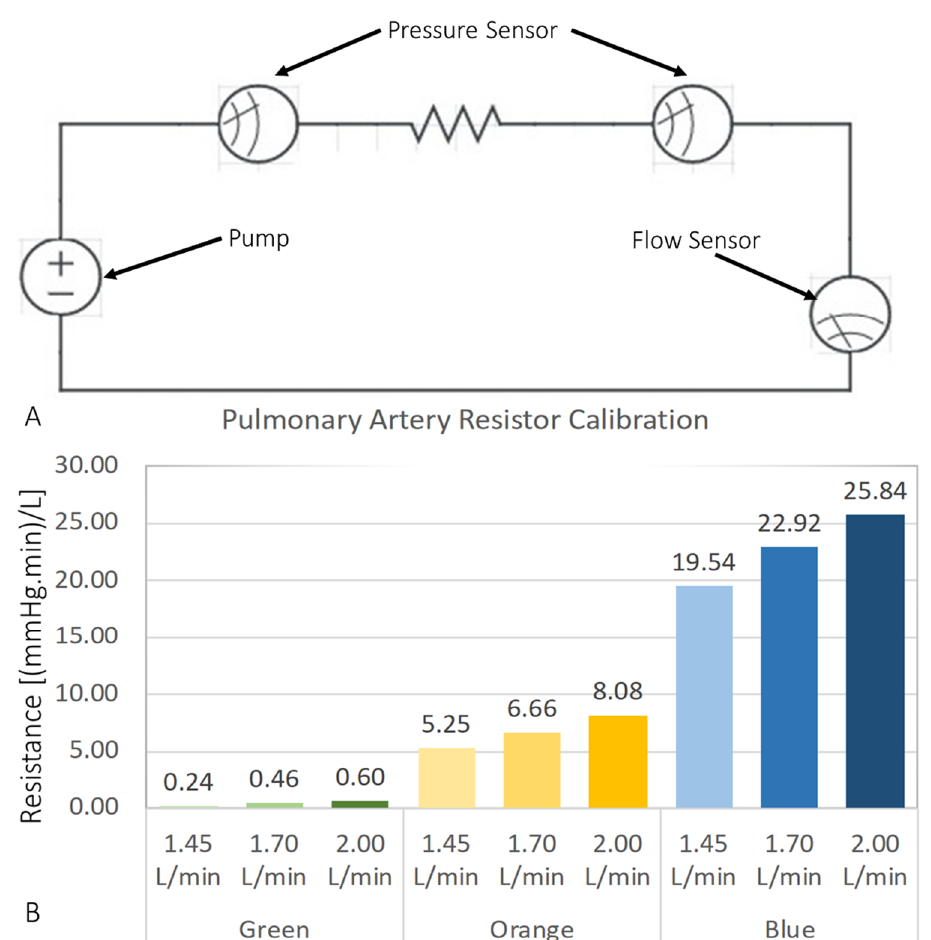
Figure 6. ( A ) Resistance calibration loop and ( B ) calibration curves for pulmonary resistances for 3 flow rates (1.45 L/min, 1.70 L/min, and 2 L/min).